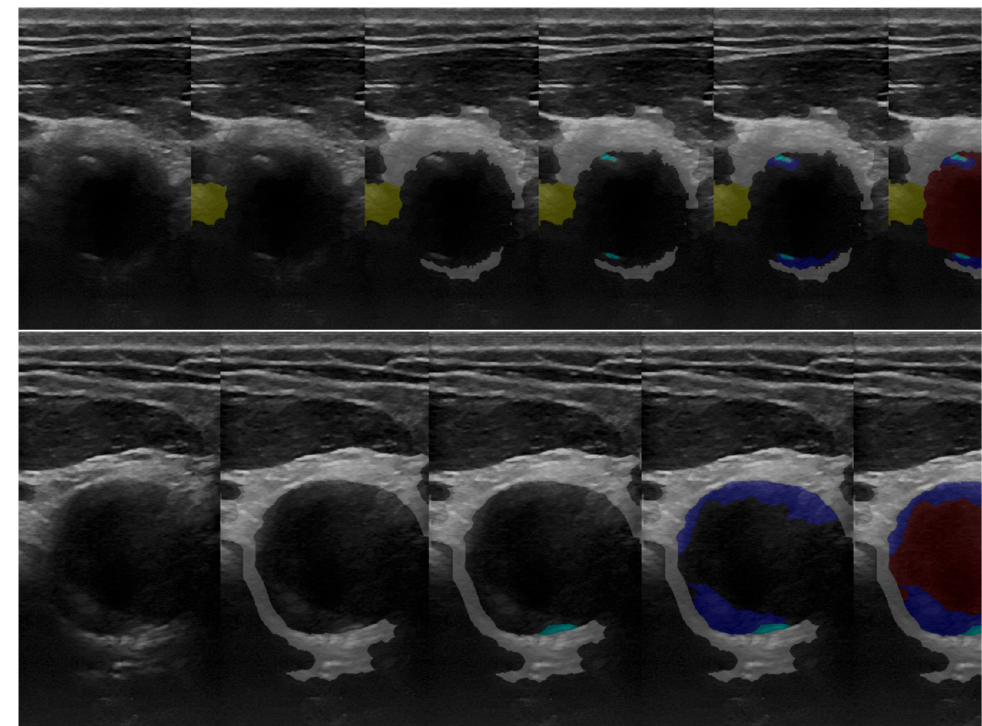
Figure 1. Manual and semiautomatic segmentation using our own software application: original US image, thyroid—yellow, carotid arterial wall—white, calcified plaque—light blue, soft plaque—dark blue, and circulated lumen—red.